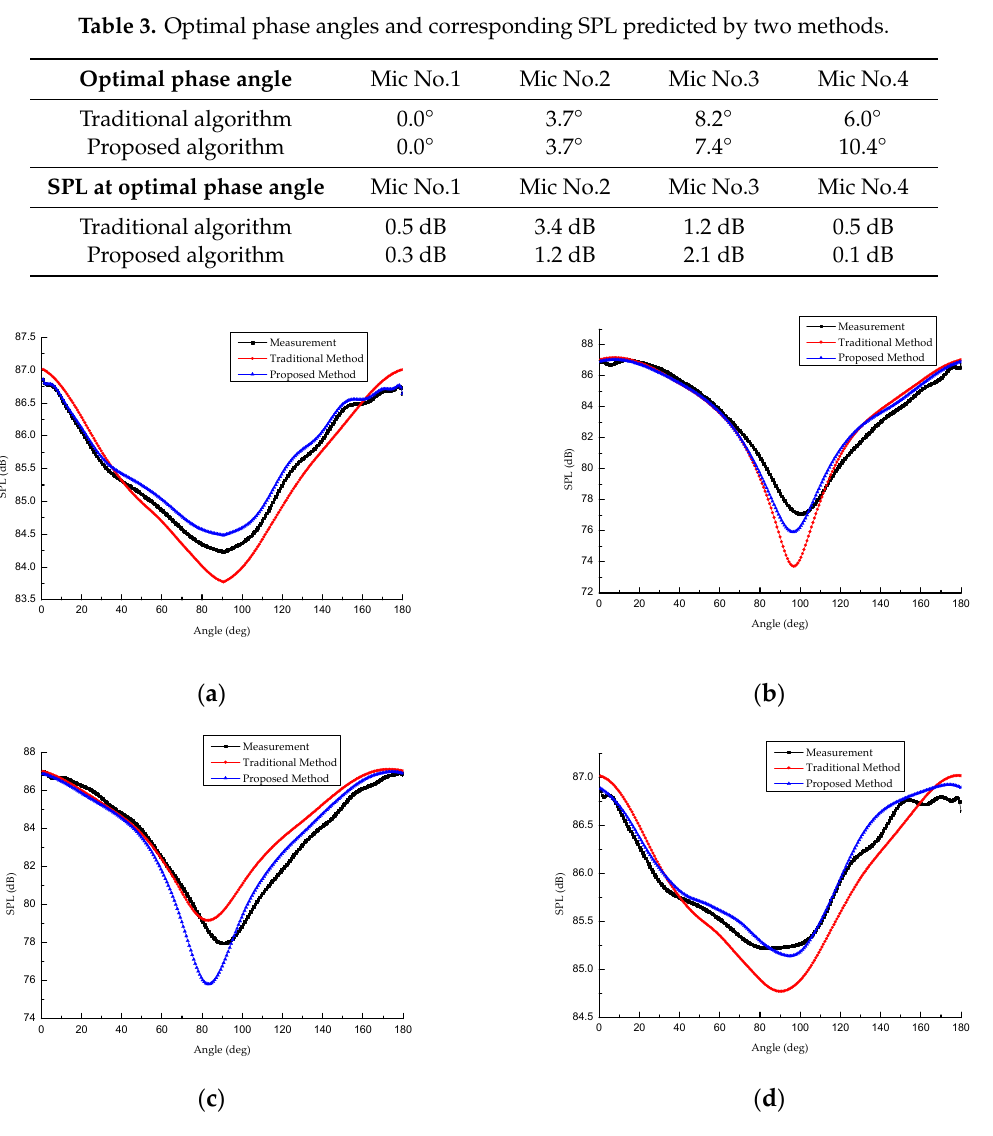
Figure 10. Comparisons of predictions versus the real noise data by the traditional and proposed algorithm: ( a ) No.1 installation hole; ( b ) No.2 installation hole; ( c ) No.3 installation hole; ( d ) No.4 installation hole.